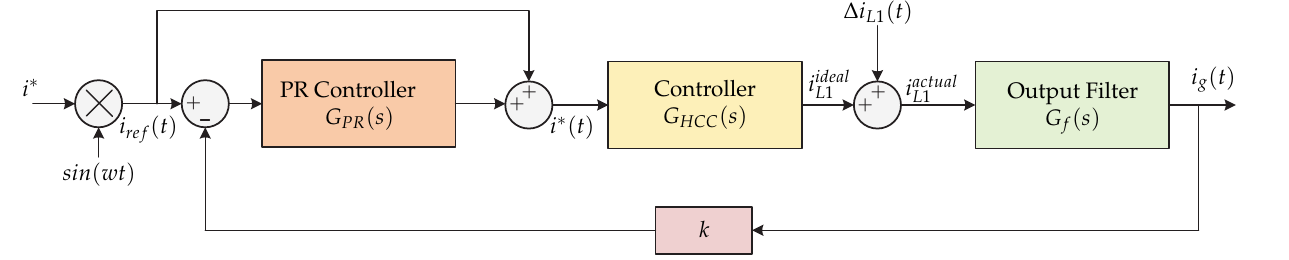
Figure 3. Control strategy proposed in [12].